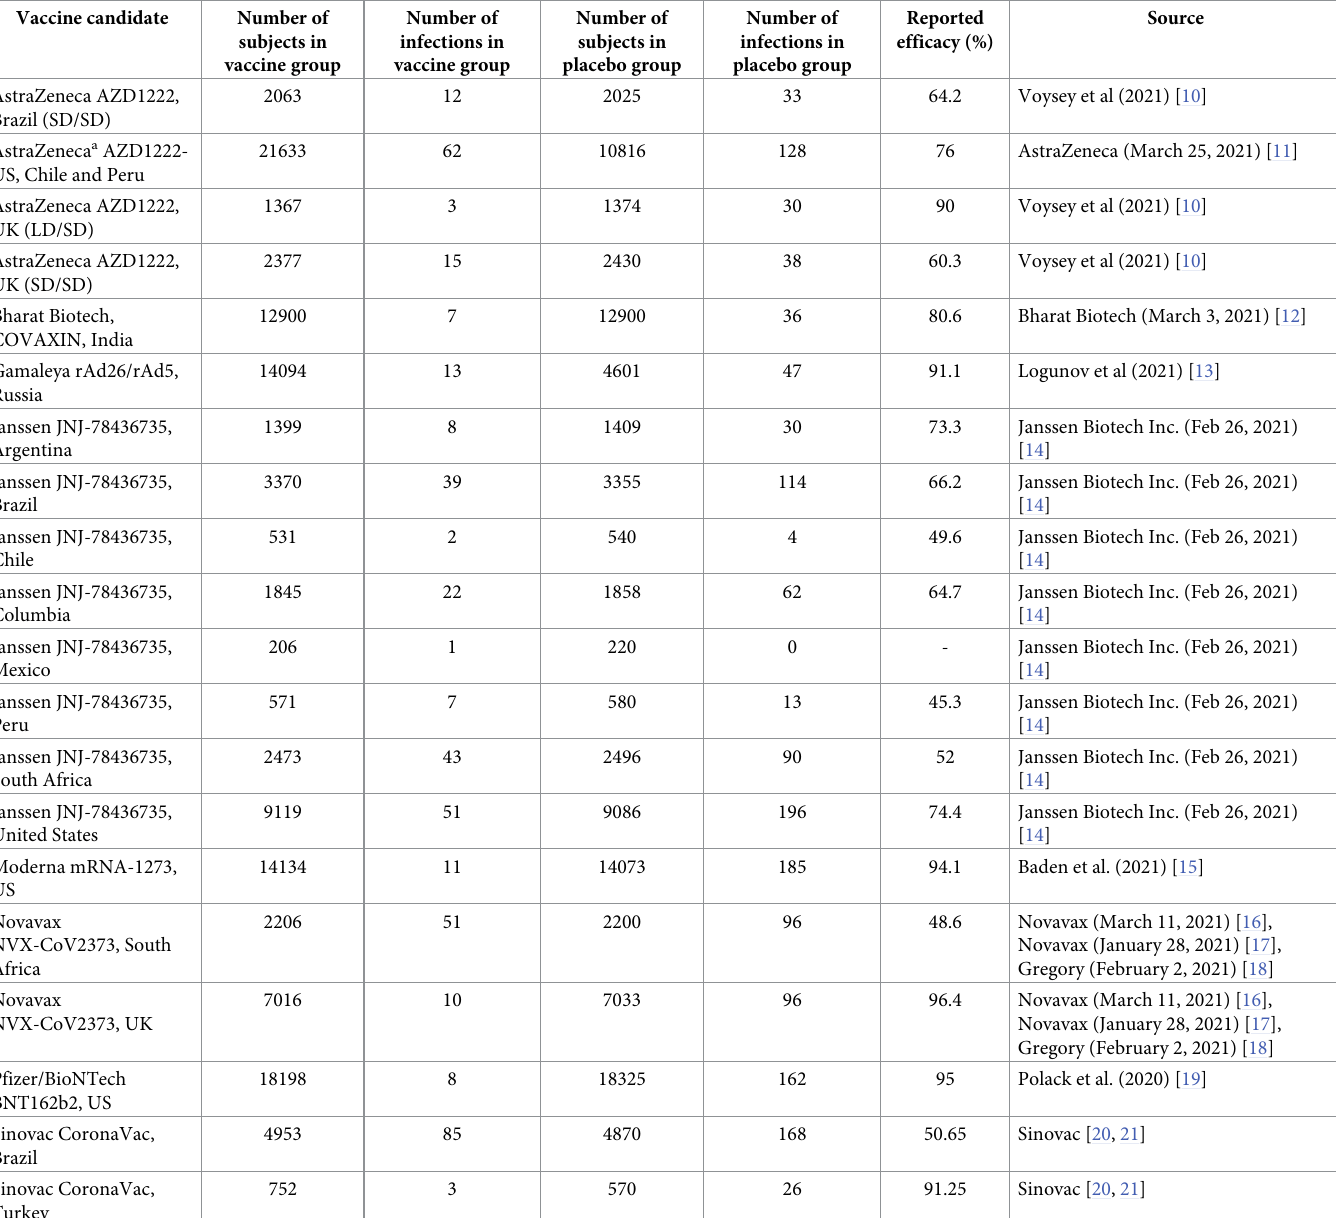
Table 1. Characteristics of phase 3 trials of SARS-CoV-2 vaccine candidates reporting